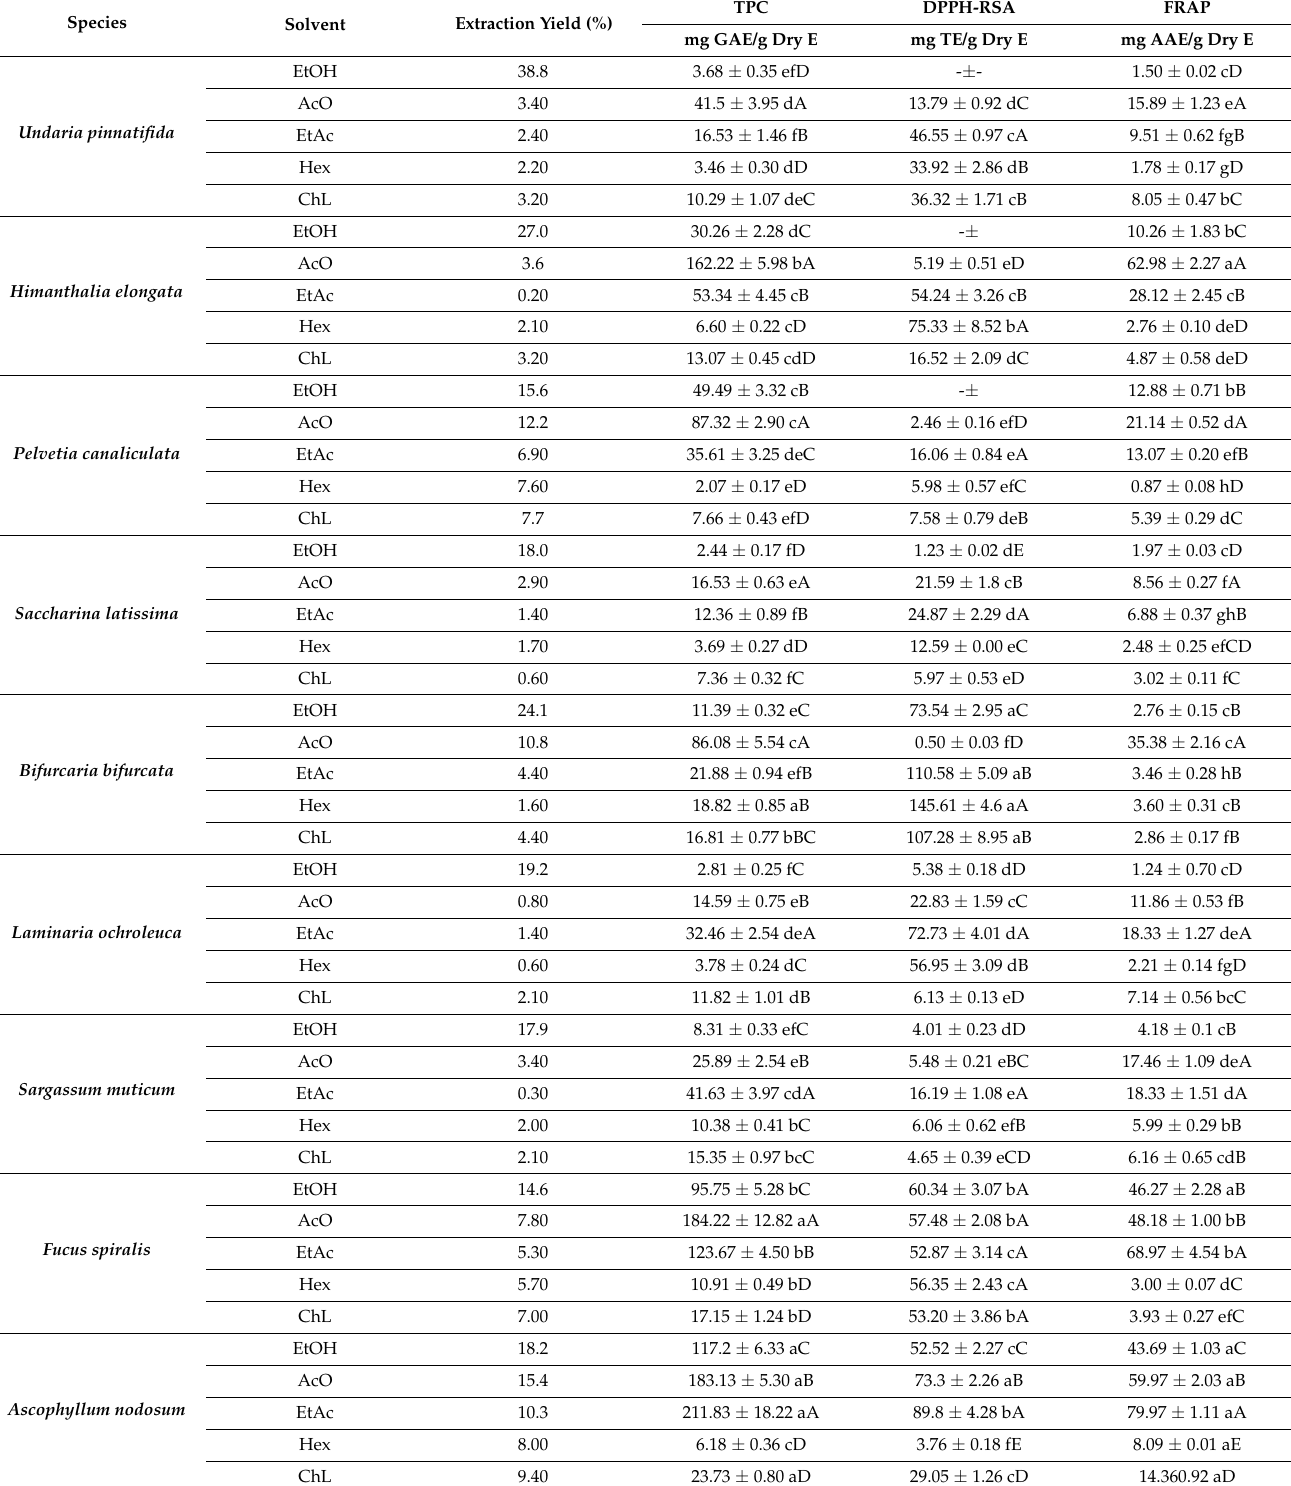
Table 1. Extraction yield, TPC, DPPH-RSA, and FRAP values of nine brown algae species extracts using five different solvents 1